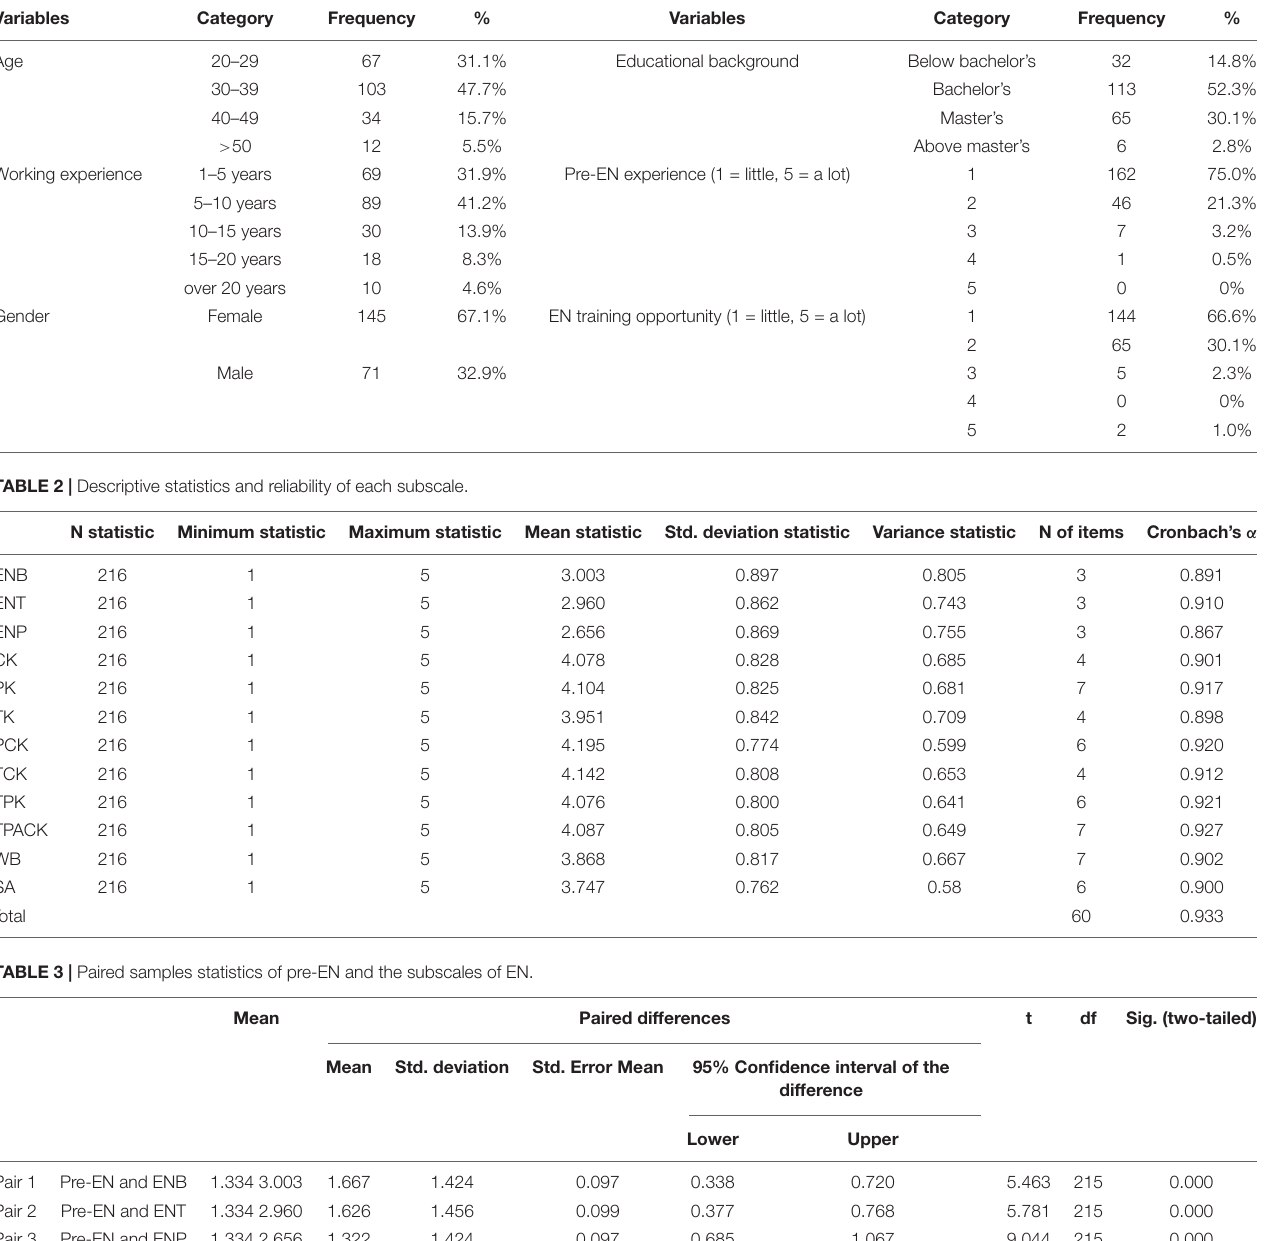
TABLE 1 | Profile of participants.